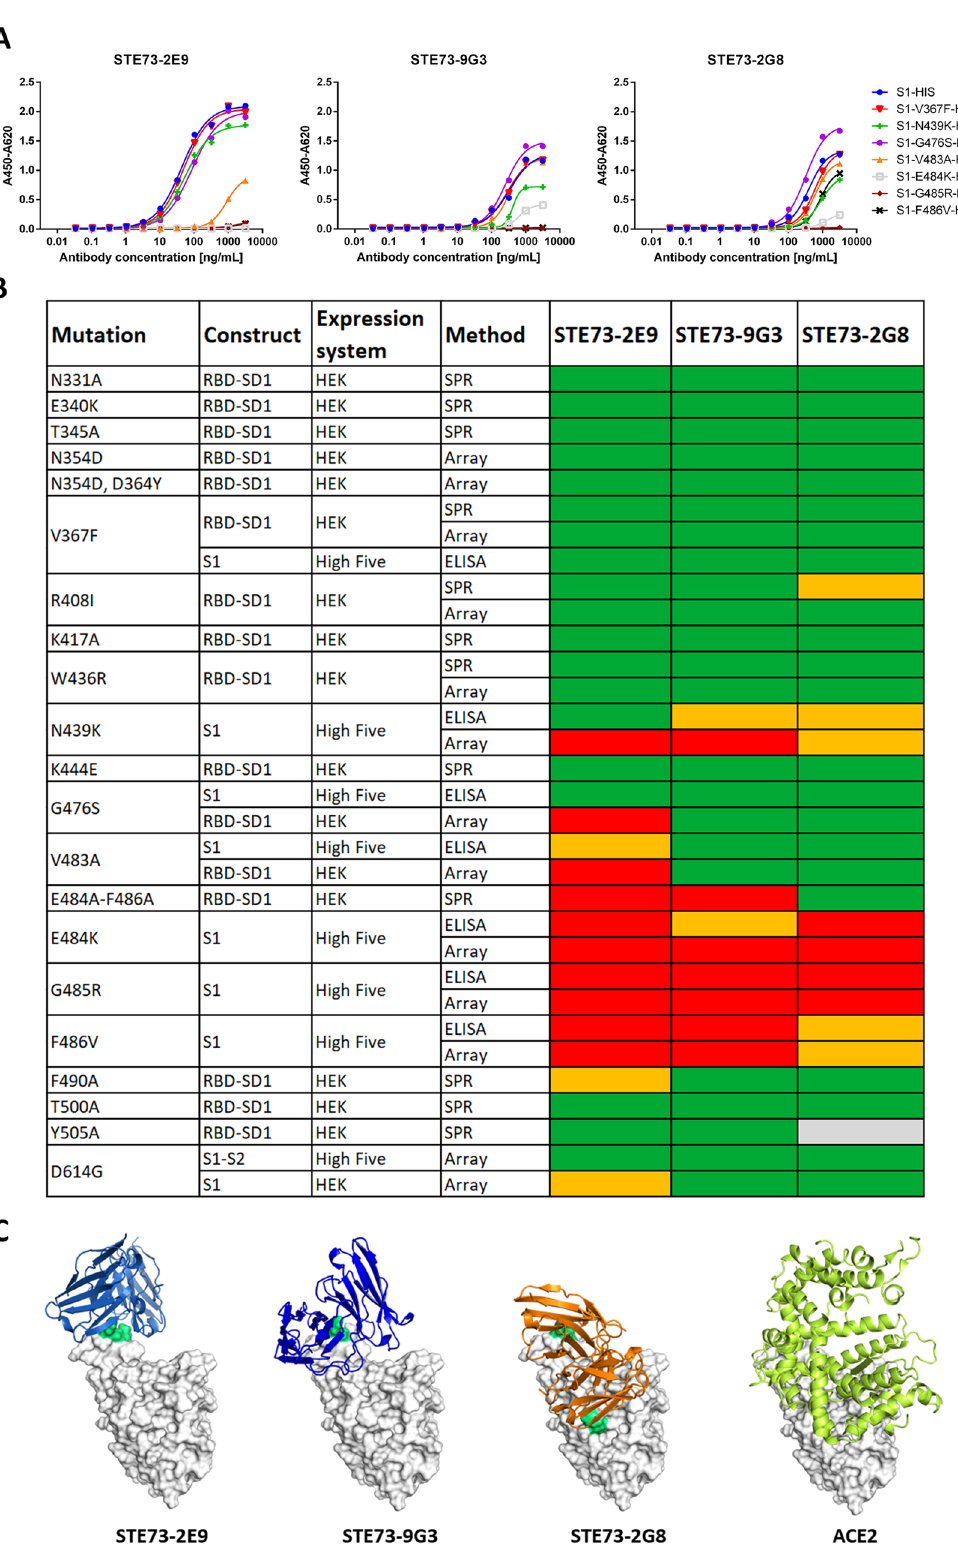
Fig. 6 Binding to RBD mutants, epitopes, and structure models. A ELISA using STE73-2E9, -9G3, and -2G8 on S1-His with different RBD mutations. B Overview of the binding of STE73-2E9, -9G3, and -2G8 to different RBD mutations analyzed by ELISA, SPR, and protein array. Sequence SARS-CoV-2 (Gene bank QHD43416). ELISA experiments were performed in duplicate and mean values are given. C The three antibodies STE73-2E9, -9G3, and -2G8 are binding to the ACE – RBD interface (docking models based on epitope data from binding to RBD mutations). Experimentally validated computational models of the variable regions of the antibodies (colored cartoons) binding to the RBD (white surface, same orientation in all images) are shown. The cartoon representation of ACE2 is also shown for